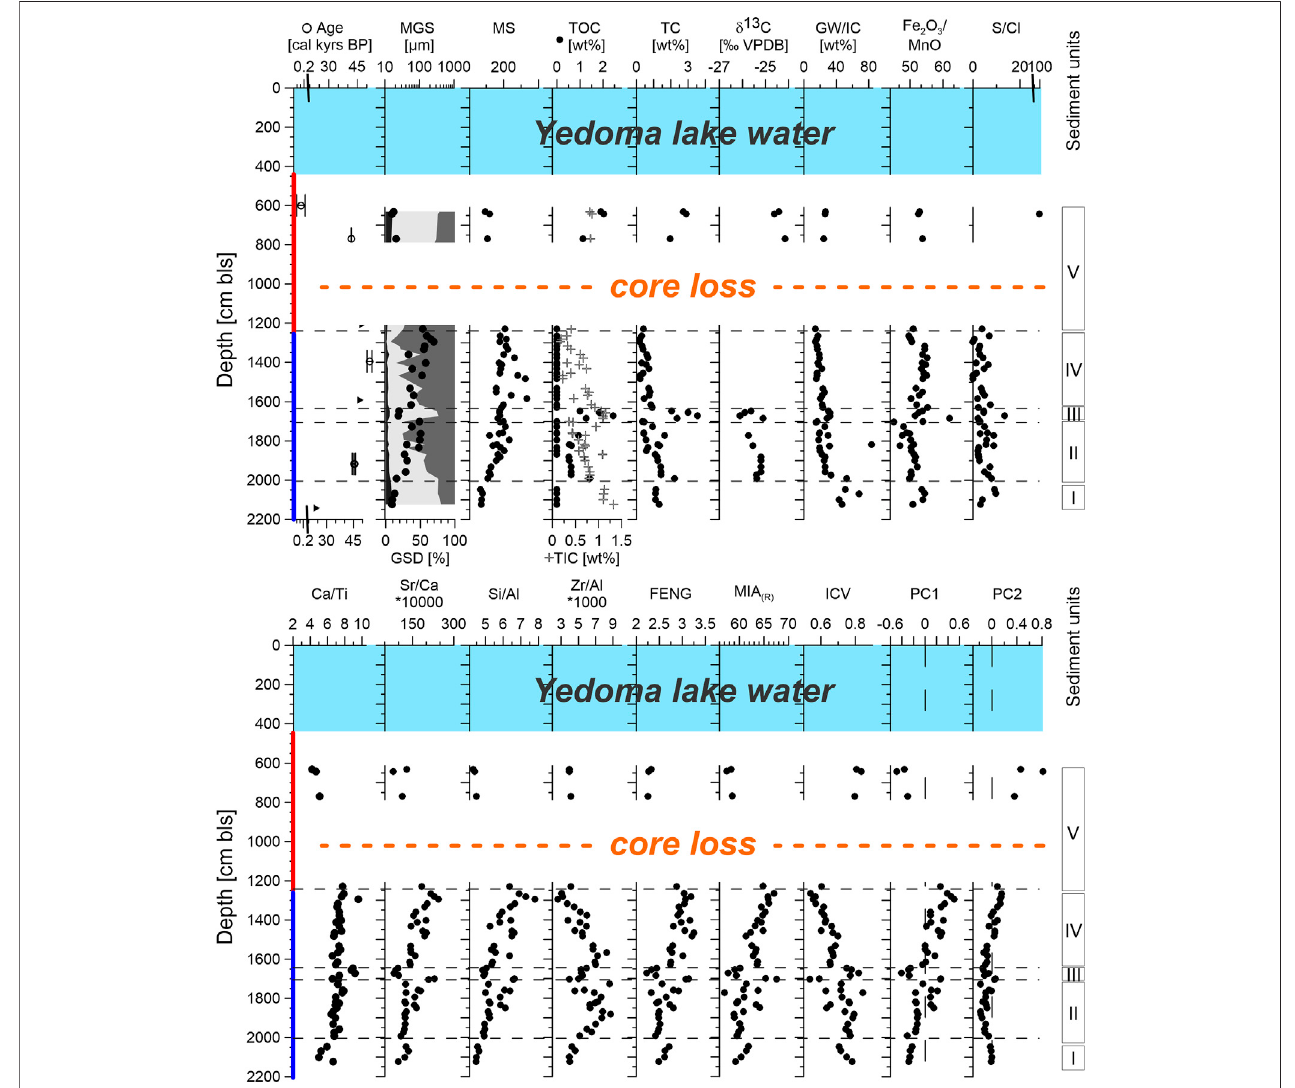
FIGURE 7 | Sedimentological parameters, organic and inorganic geochemistry as well as the weathering indices FENG, MIA (R) , ICV and the Principal components (PC) oftheYedoma lakecoreYU-L15 (Mean grain size(MGS);Grain-sizedistribution(GSD); Mass-speci fi cmagnetic susceptibility(MS);Ground water/icecontent(GW/ IC)). In fi nite radiocarbon dates are illustrated by triangles. Unfrozen core depth intervals are marked by red depth scale while frozen ones are marked in blue.